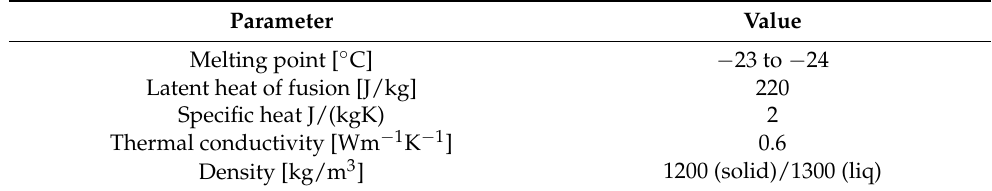
Table 1. Physical properties of the applied Rubiterm SP-24 phase change material. Adapted from [20].